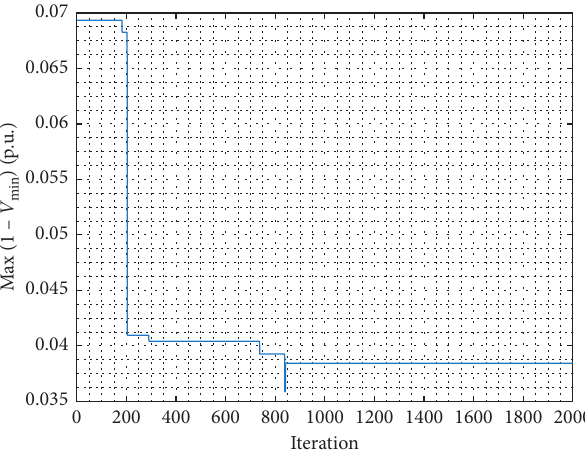
Figure 15: Convergence characteristic of voltage deviation for the 136-bus system.